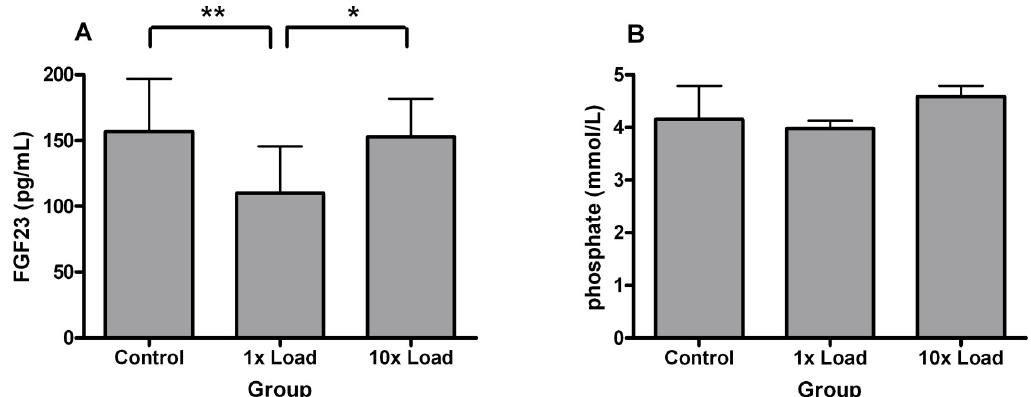
Fig 3. (A and B): Serum concentration of intact FGF23 (A) and inorganic phosphate (B). Rats in the control group (n = 19) received no mechanical loading. Rats in the 1x Load group (n = 24) received a single bout of mechanical loading of the right tibia and were sacrificed 6 hours later. Rats in the 10x Load group (n = 9) received a single bout of mechanical loading of the right tibia every workday for two weeks and were sacrificed 6 hours after the last bout of mechanical loading. Blood samples were collected at sacrifice and FGF23 and inorganic phosphate were measured in serum. Values are means ± SD. �� p <